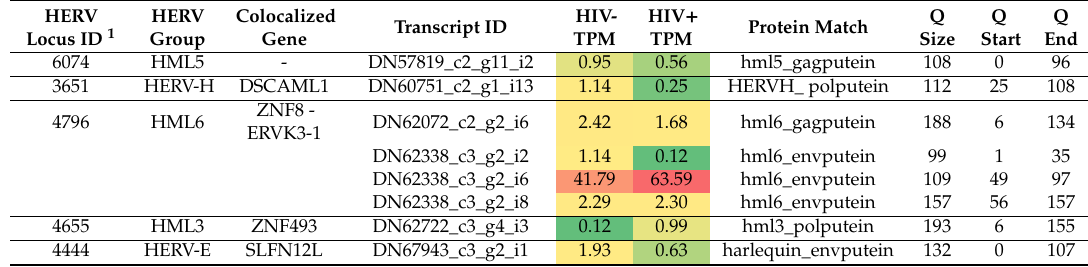
1 ID referred to Vargiu et al. 2016. Q = query. TPM values are represented with a color gradient from red (highest) to green